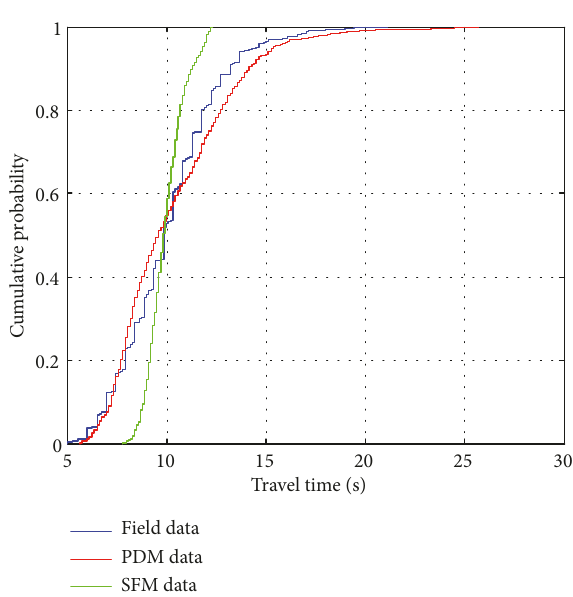
Figure 12: Cumulative probability curve of the travel time at the Changji-Moyu